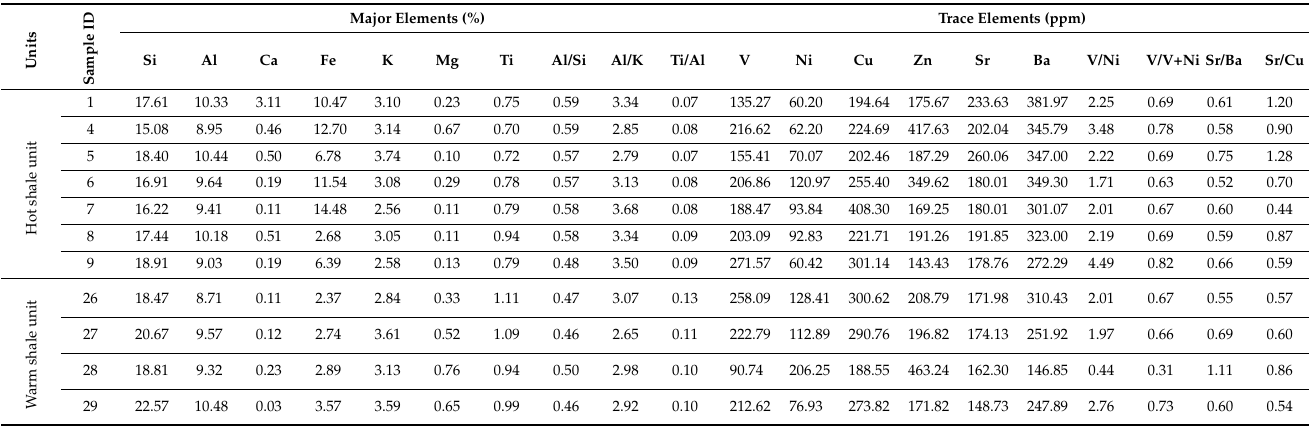
Table 3. Major and trace elements (X-ray fluorescence analysis) of the analyzed dark shales from the Silurian Qusaiba Formation in the Tayma Basin, Northwestern Saudi